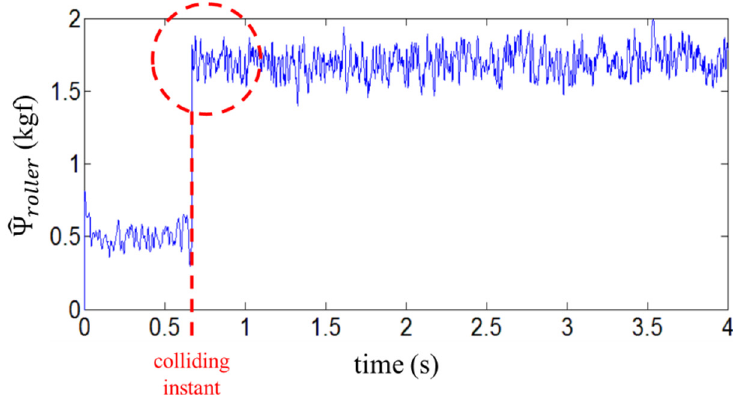
Figure 5. Graph of estimated perturbation of upper roller.